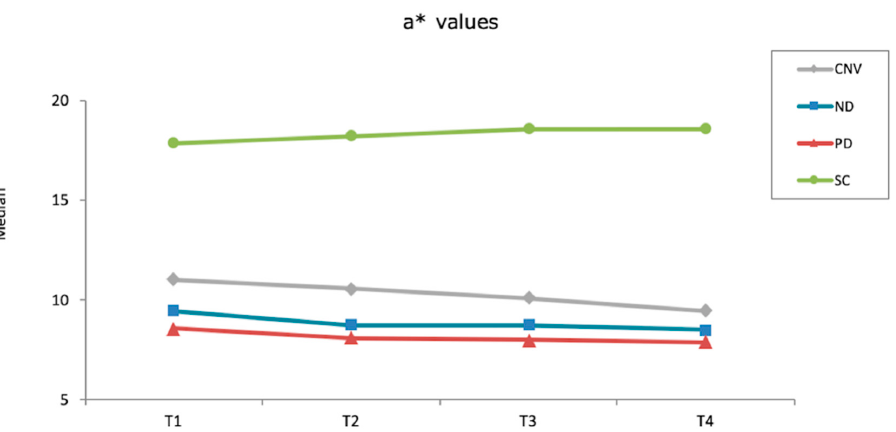
Figure 2. a* values of each material after each procedure (T1: After polish; T2: After first brushing cycle; T3: After thermocycling; T4: After second brushing cycle).